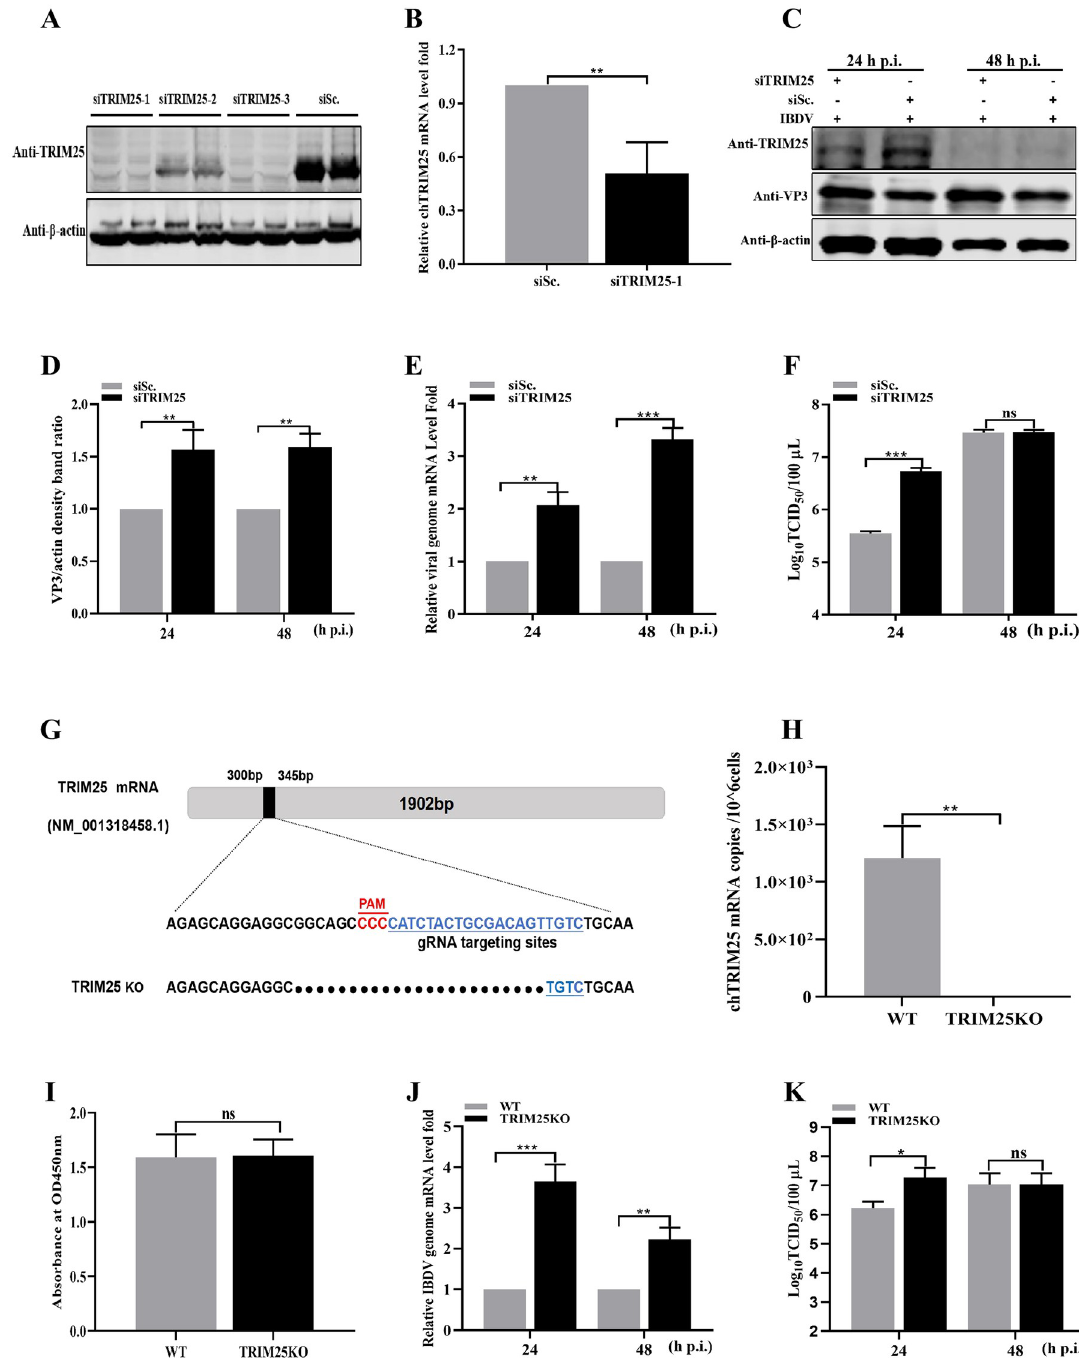
Fig 3. TRIM25 knockdown/knockout enhances IBDV replication. (A-B) Validation of the optimal siRNA targeting TRIM25 by Western blotting (A) and RT-qPCR (B). (A) HEK293T cells were co-transfected with siRNAi (siTRIM25-1, siTRIM25-2, siTRIM25-3, and negative siRNA control siSc.) and pFlag-TRIM25, and the expression level of TRIM25 was determined using Western blotting. (B) DF-1 cells were transfected with siTRIM25-1, and the expression levels of endogenous TRIM25 were detected by RT-qPCR. (C-F) Influence of knockdown of TRIM25 on IBDV replication. The DF-1 cells were transfected with 2 μ g siTRIM25-1 or negative siRNA control siSc. for 24 h and subsequently were infected with IBDV at an MOI of 0.01 for 24 and 48 h, respectively. (C) Expression levels of TRIM25 and VP3 were determined by Western blotting. (D) Relative intensities of VP3 were normalized to β -actin. (E) Relative IBDV genome mRNA level in cell samples was quantified by RT-qPCR. (F) Released viral titers were detected and illustrated using a TCID 50 assay. (G-I) Construction of TRIM25KO DF-1 cell line. (G) Sequence analysis of WT and TRIM25KO DF-1cell lines. (H) TRIM25